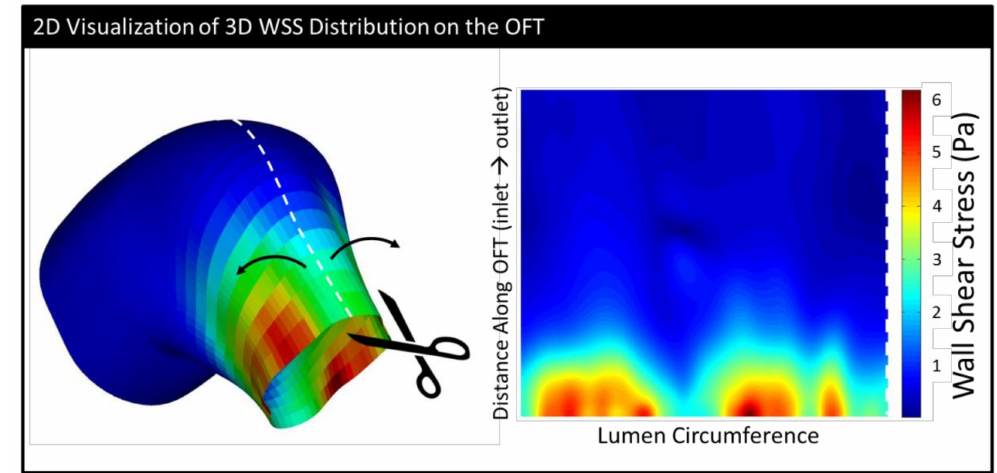
Figure 4. A schematic showing how the wall shear stress distribution on the endocardium is represented in 2-D. The surface of the endocardium is “cut” along the top and “unrolled” so that in the 2-D image, the inlet is at the bottom and the outlet is at the top. (The surface depicted is from an HH18 embryo at the point of maximum wall shear stress